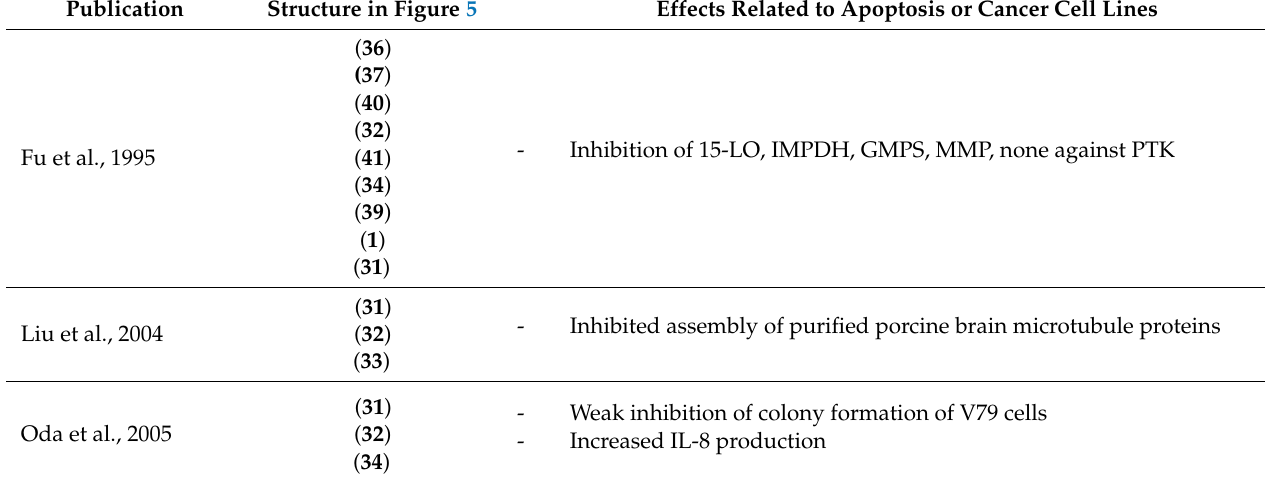
Table 2. Literature summary on bioactivity data of naturally derived and isolated PBDEs in relation to apoptosis and cancer. The literature about PBDEs was screened for data about bioactivity related to apoptosis or cancer cell lines. The corresponding publication is listed together with investigated compounds (structures are shown in Figure 5) and respective biological